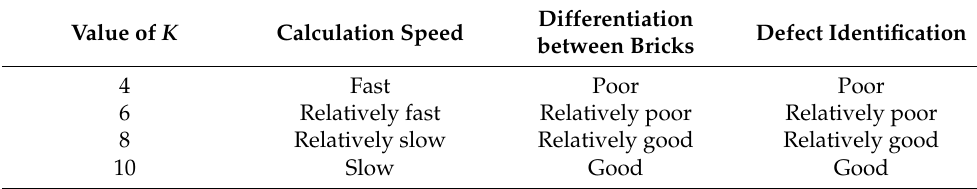
Table 3. Feature calculation speed, di ff erentiation between bricks, and defect identi fi cation ability under di ff erent values of K .